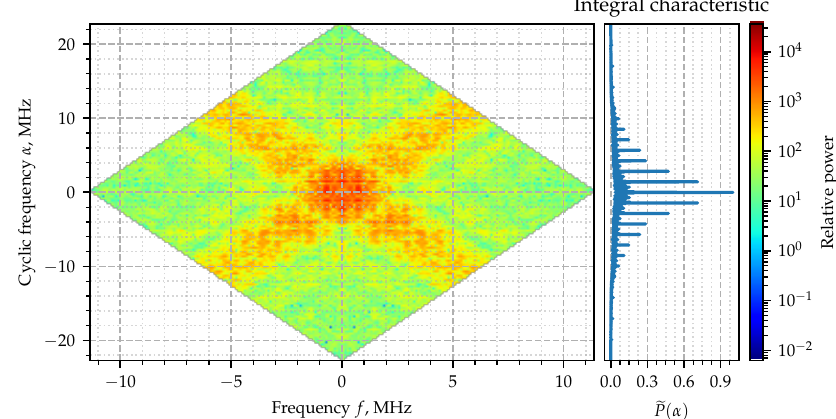
Figure 9. Estimated spectral correlation density of the PAM signal.